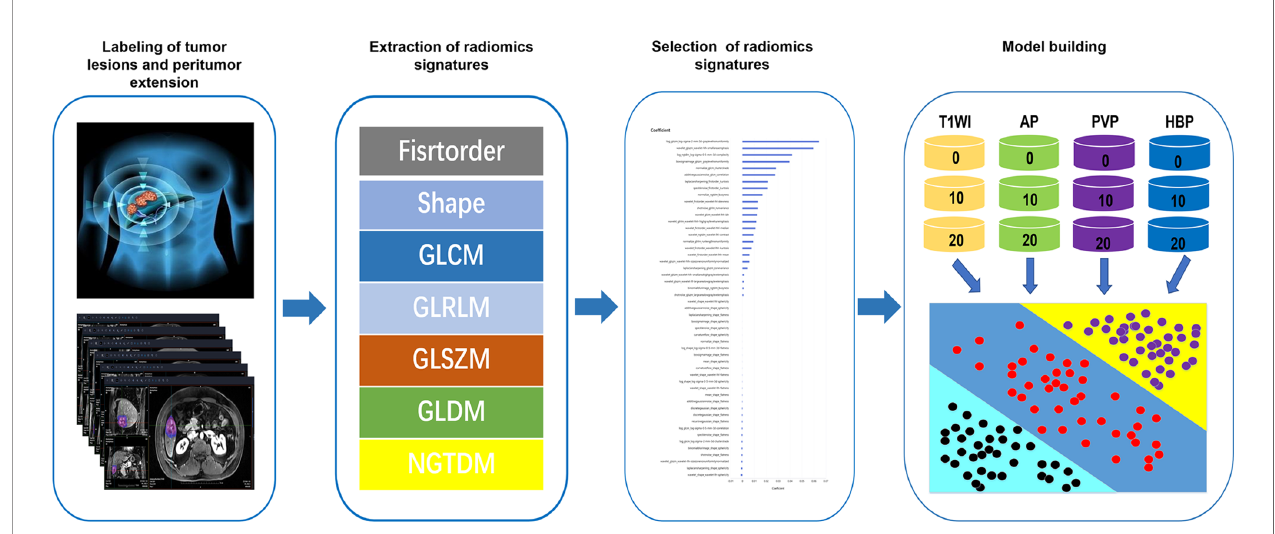
FIGURE 1 | Work fl ow of radiomics analysis. The radiomics work fl ow started with labeling of tumor lesions and peritumor extension in MR images. After that, radiomic features including fi rstorder, shape, gray-level co-occurrence matrix (GLCM), gray-Level run-length matrix (GLRLM), gray-level size zone matrix (GLSZM), gray level difference method (GLDM) and neighborhood gray-tone difference matrix (NGTDM) were extracted within the tumor and peritumor dual-region. Next, least absolute shrinkage and selection operator (LASSO) were used for the radiomic feature selection. Finally, unimodal radiomics models and multimodal radiomics models based on different regions of interest (ROIs) in the tumor and peritumor was developed.